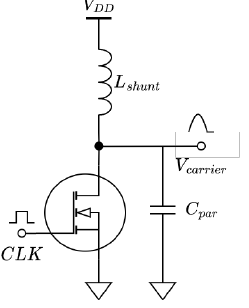
Figure 9. Modified class-E